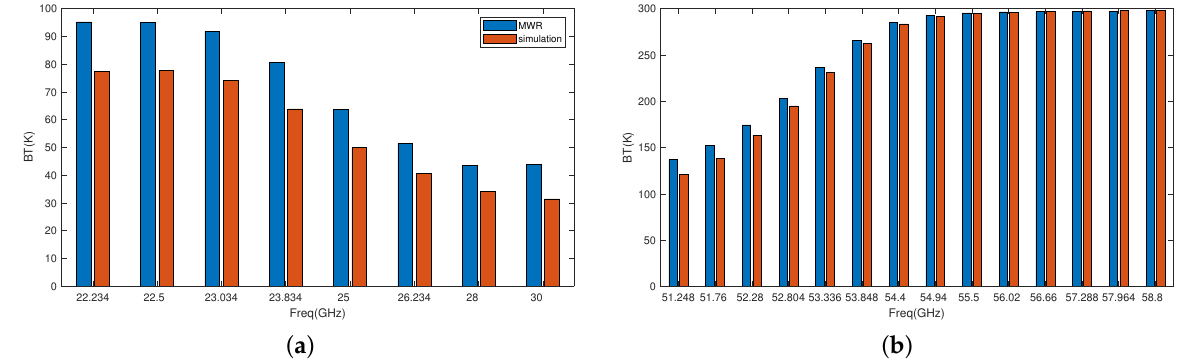
Figure 1. The mean value of BTs in water vapor band ( a ) and oxygen band ( b ) in July 2018, Dachen